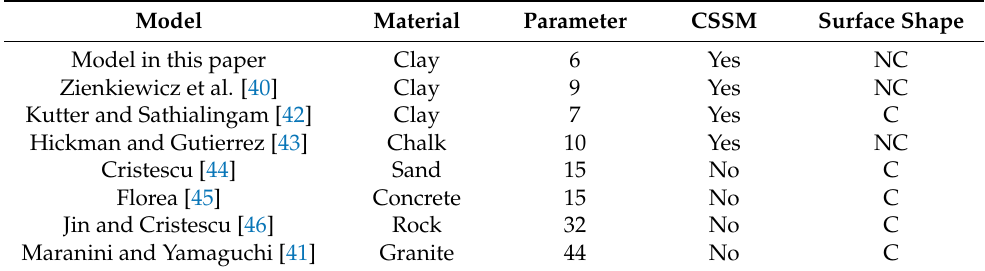
Table 1. Summary of the EVP models using the non-associated flow rule for different geomaterials. Model Material Parameter CSSM Surface